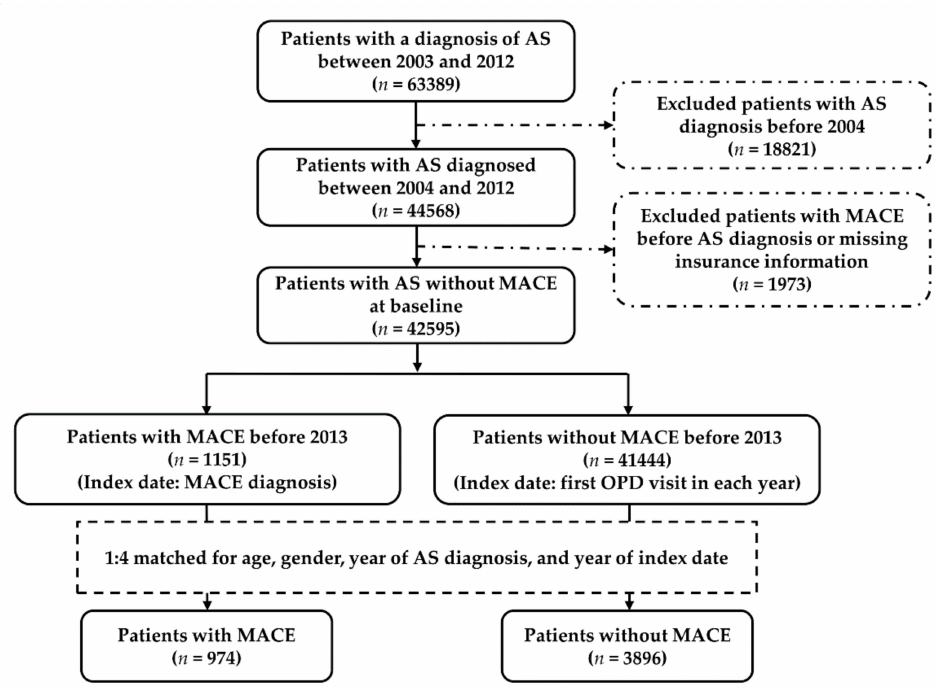
Figure 1. Flow diagram of enrolment, categorisation, and matching for comparison of the study population. AS, ankylosing spondylitis. MACE, major adverse cardiovascular event. OPD, outpatient